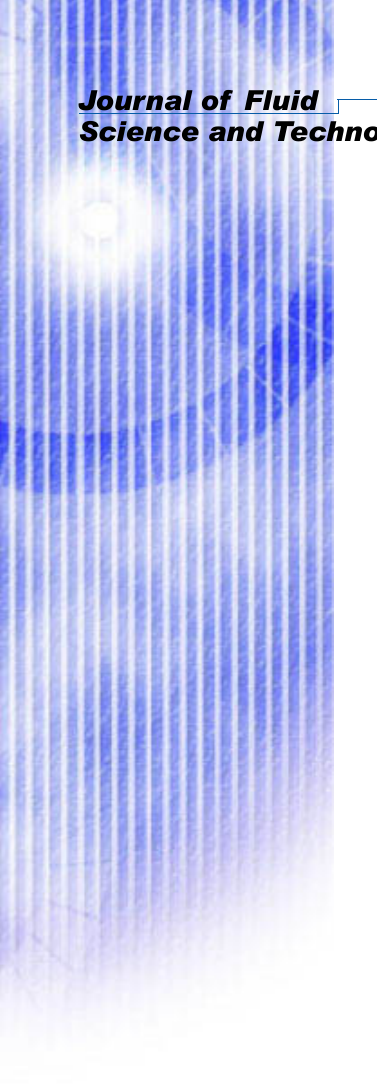
Fig. 7 Cavitating jet in enlarged model (Re=2.89 x 10 4 , σ